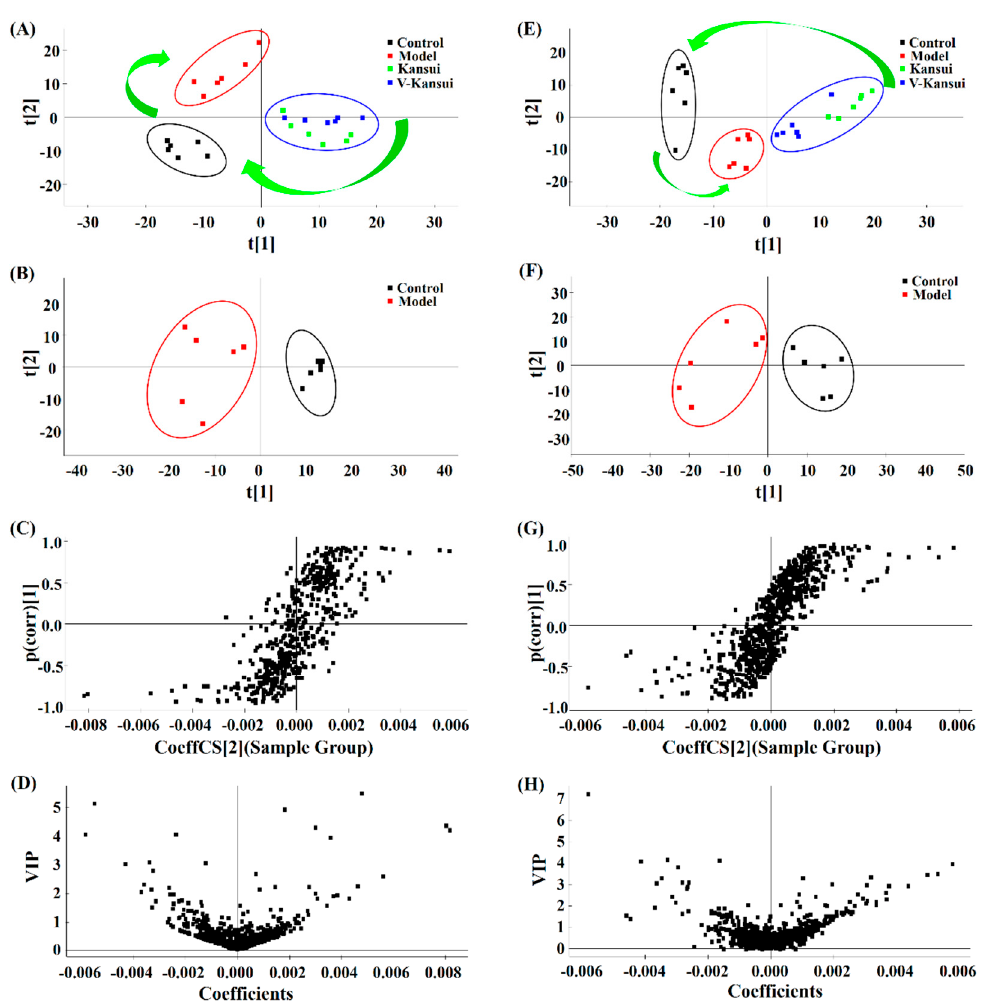
Figure 1. The PCA score plots ( A , E ) of four groups, PCA score plots ( B , F ), S-plots ( C , G ) and VIP-plots ( D , H ) of OPLS-DA between control and model groups in positive ESI mode of serum and urine samples. A – D represents the serum samples while E – H represents the urine samples.